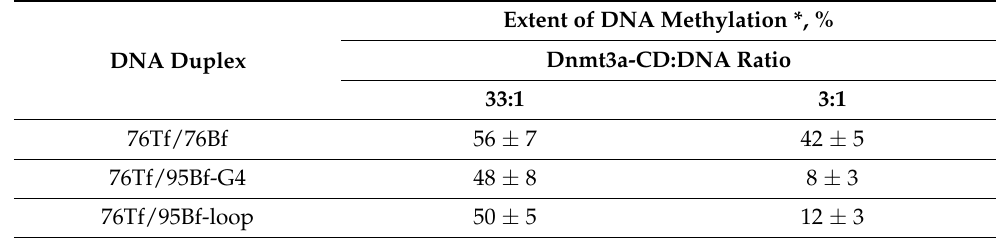
Table 2. Extent of methylation of DNA duplexes at different Dnmt3a-CD:DNA ratios. Extent of DNA Methylation *, % DNA Duplex